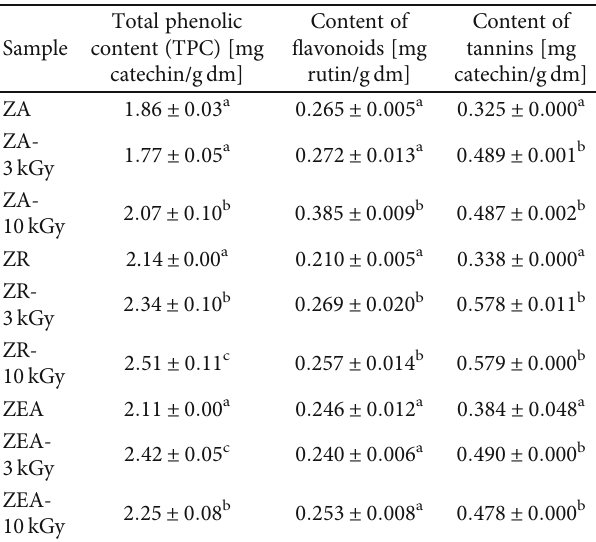
Table 2: Polyphenols, fl avonoids, and total tannin content in grains of rye varieties before and after